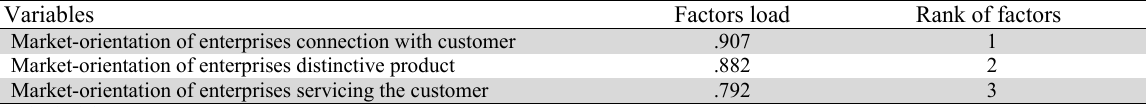
The summary of market orientation factors influencing the privatization Variables Factors load Rank of factors Market-orientation of enterprises connection with